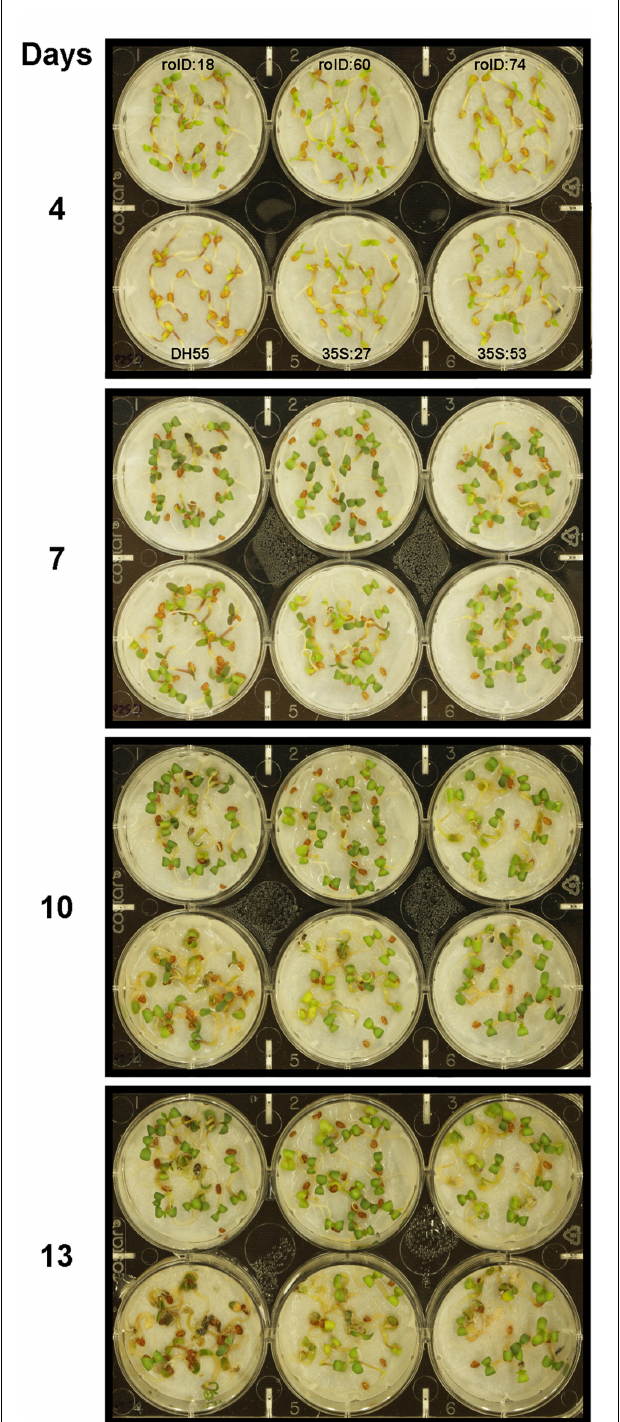
FIGURE 8 | Growth and survival of camelina seedlings in the presence of salt (20 dSm − 1 ). Lines tested include wild-type C. sativa DH55 or independent, single insert, homozygous transgenic lines expressing the acdS gene under the control of the root-specific rolD promoter or the constitutive CaMV 35S promoter. The grid in the top panel applies to all panels in the figure.